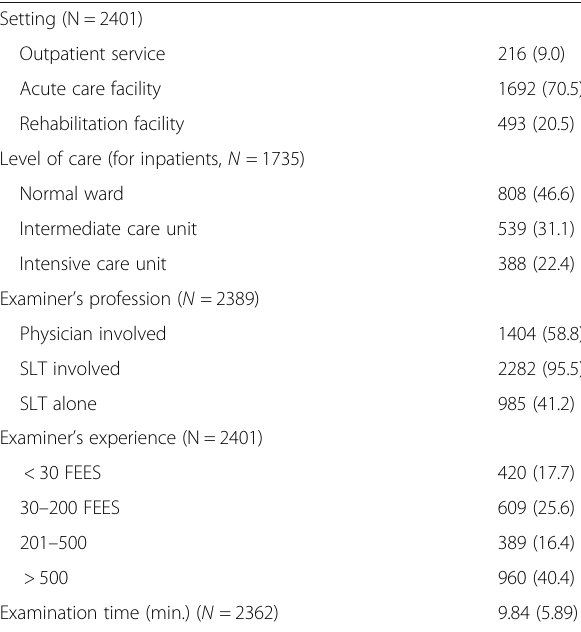
Table 2 Features of the clinical context, in which FEES was carried